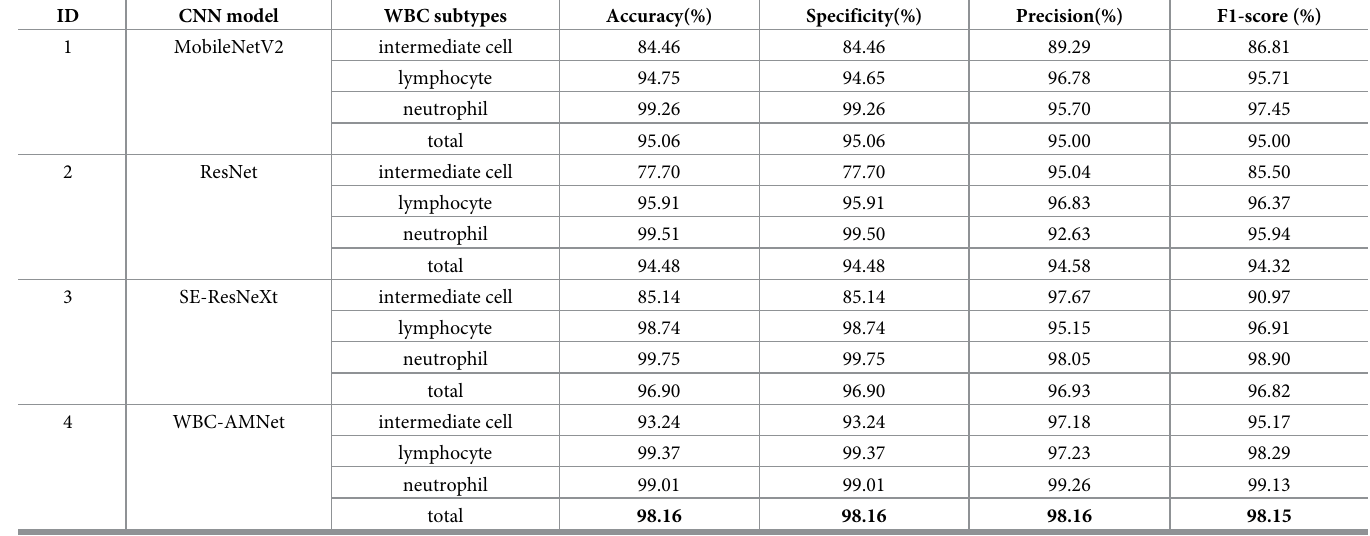
Table 8. Tri-classification results of images from WBCs dataset.